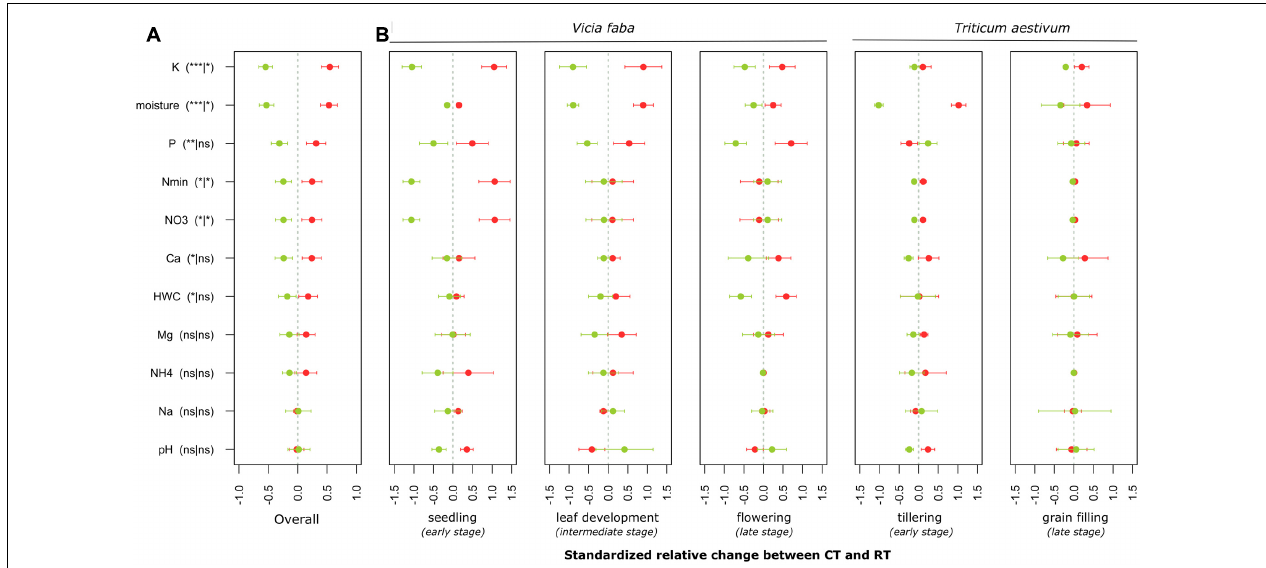
FIGURE 2 | Standardized relative changes in physical and chemical soil properties combined over all growing stages (A) as well as for each individual stage (B) between CT (red) and RT (green). Data were z-transformed, representing values greater or smaller than the average across all samples. The significance of the PERMANOVA test is indicated in brackets: the first argument represents the significance of tillage effect and the second represents the significance of the interaction between tillage and growing stage. K, potassium; P, phosphorus; Nmin, mineral nitrogen; NO − 3 , nitrate; Ca, calcium; HWC, hot water carbon; Mg, magnesium; NH 4 + , ammonium; Na, sodium. CT, conventional tillage; RT, reduced tillage; ∗∗∗ q < 0.001, ∗∗ q < 0.01, ∗ q < 0.05; ns, not